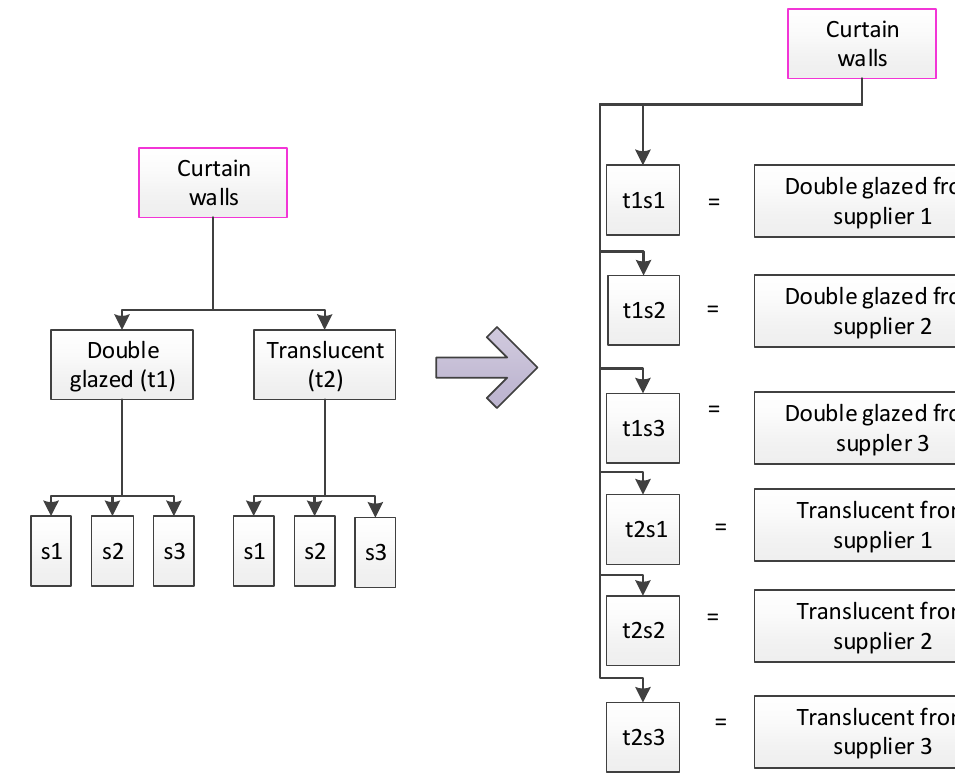
Figure 4. Preprocessing with an example of curtain